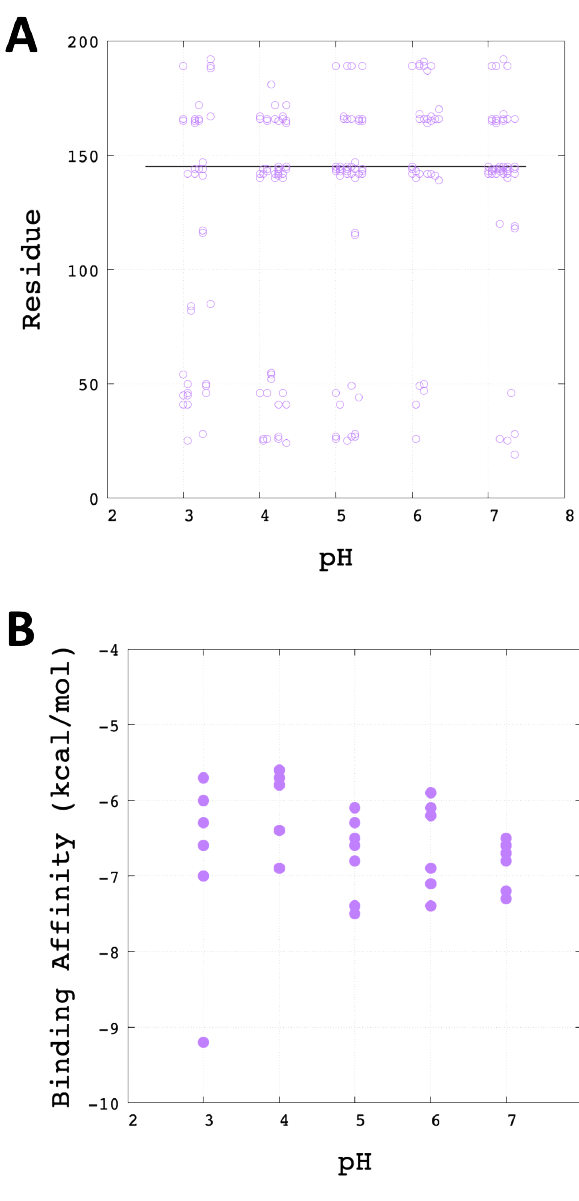
Figure 10. Binding analysis. ( A ) Mpro residues that interact with the drug PF-00835231 through hydrogen bonds at different pH (3, 4, 5, 6 and 7). For each pH, the best docking of each of the 8 microstates is analysed. To distinguish between the different docking poses, each is shifted slightly on the pH axis. A horizontal line is also depicted at 145 to help visualise the interaction with the catalytic Cys145. ( B ) The predicted binding affinity of drug PF-00835231 with Mpro at different pH. For each pH, the best binding affinity of the 8 different microstates is